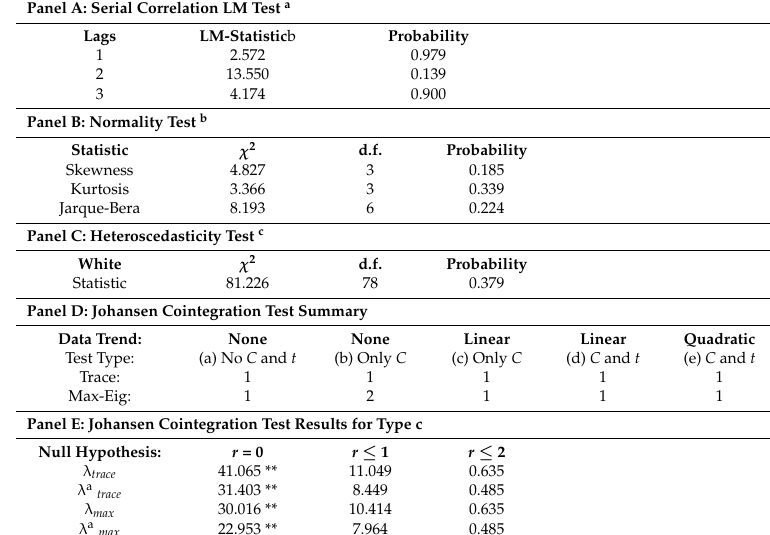
Table 4. The Vector Autoregressive model residual diagnostics and cointegration tests